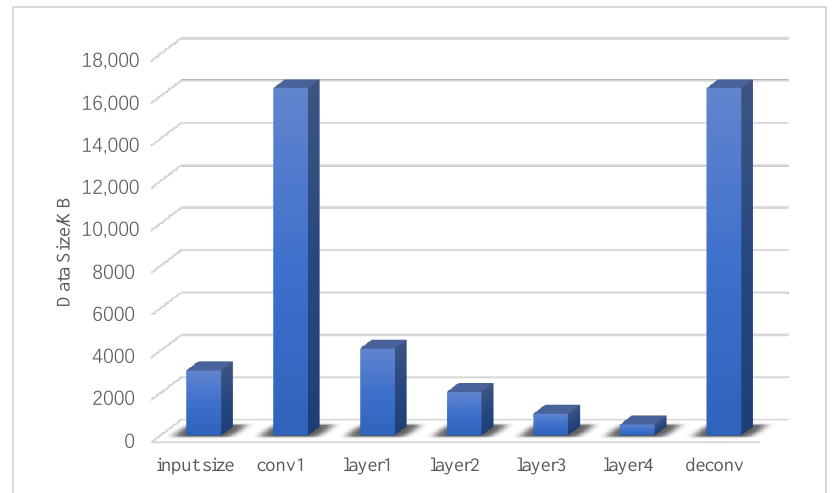
Figure 3. Output n data size of different layers of